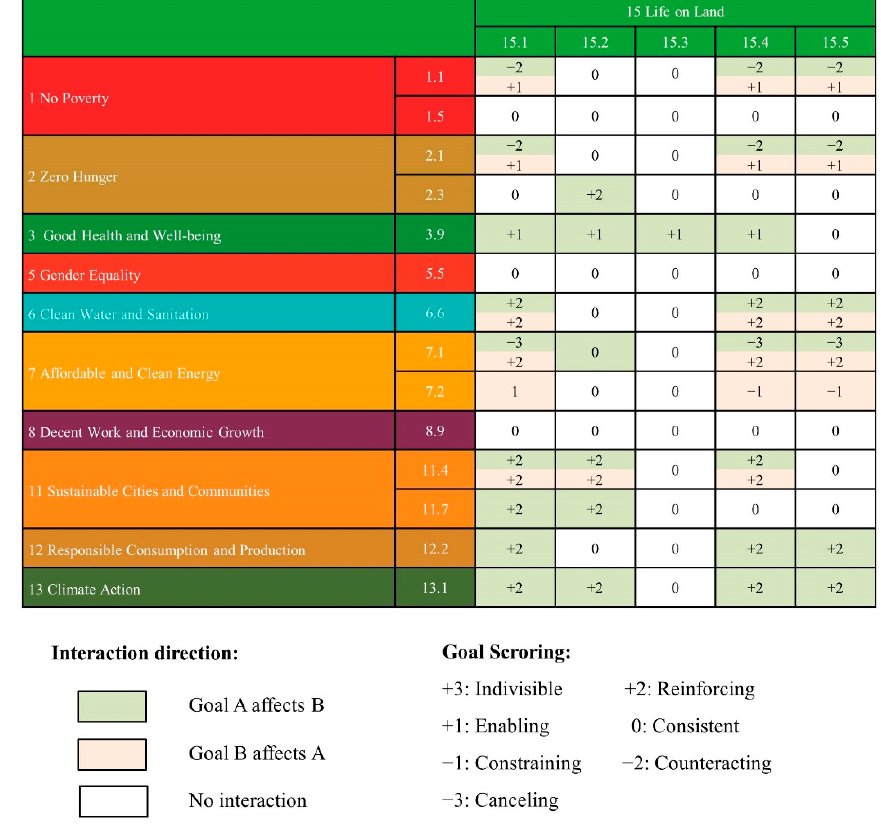
Figure 3. Interactions between SDG15 and other SDGs at the target level. Goal A represents SDG15 and Goal B represents other SDGs related to forestry.